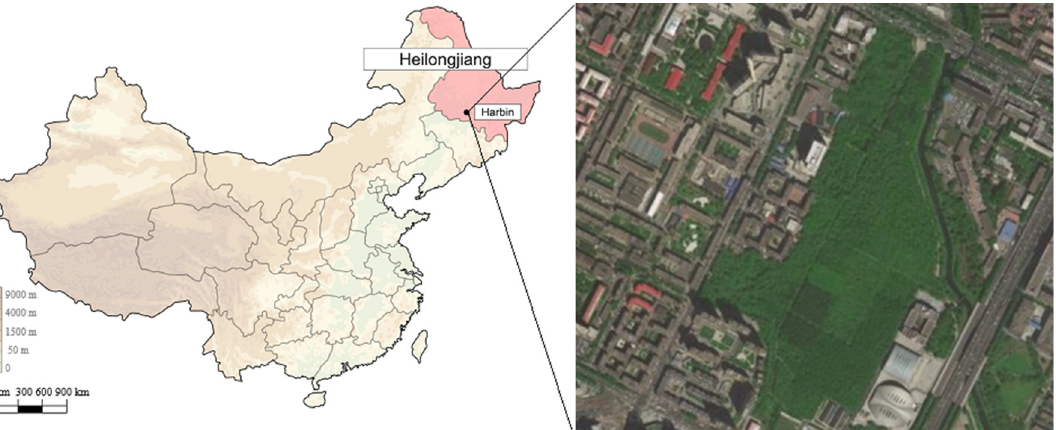
Figure 1. The satellite image of the Urban Forestry Demonstration Base of Northeast Forestry University and its geographical location in China.